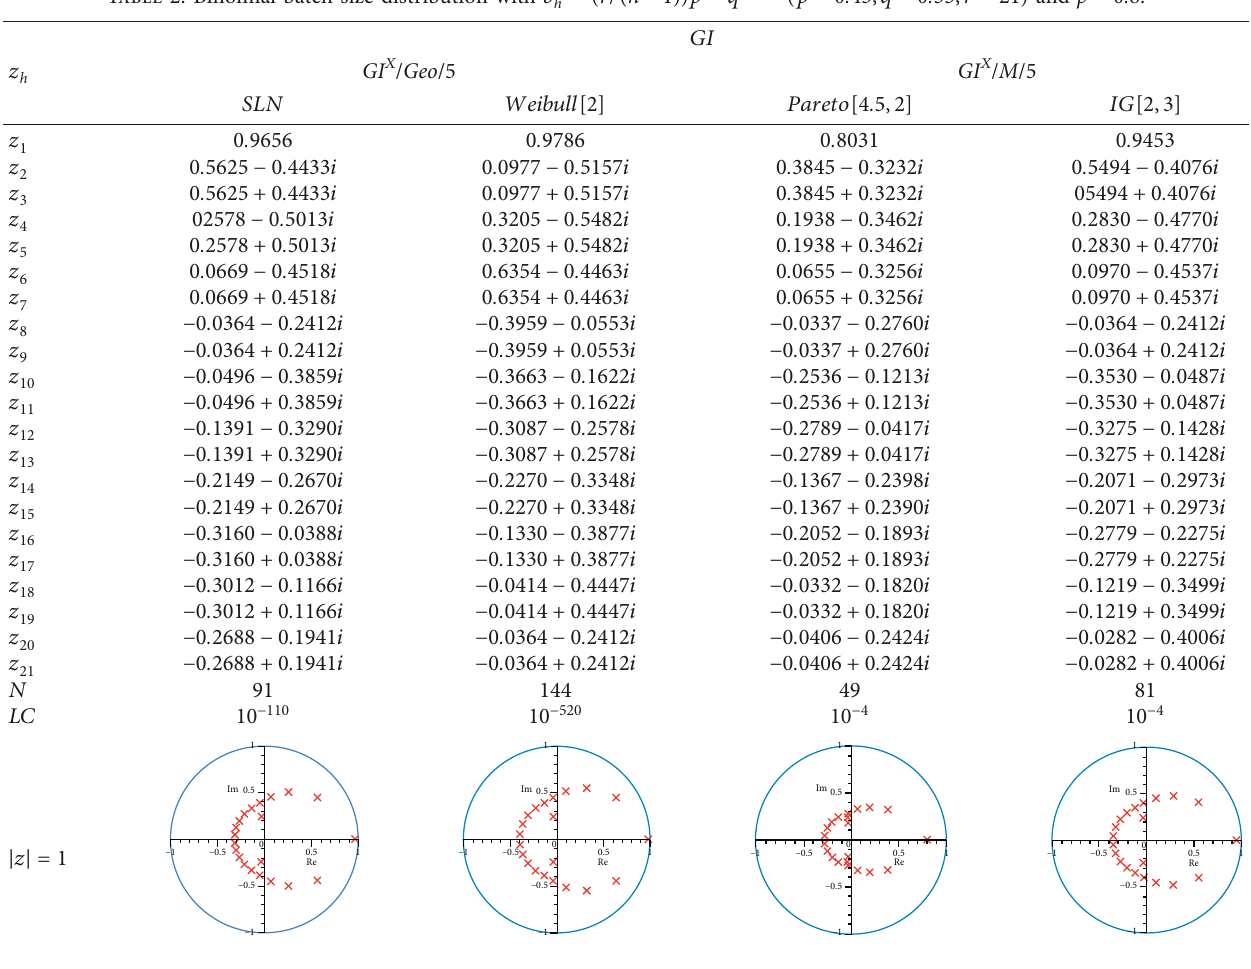
� ( r / ( h − 1 )) p h − 1 q r − h + 1 ( p � 0 . 45 ,q � 0 . 55 ,r � 21 ) and ρ � 0 . 8. h